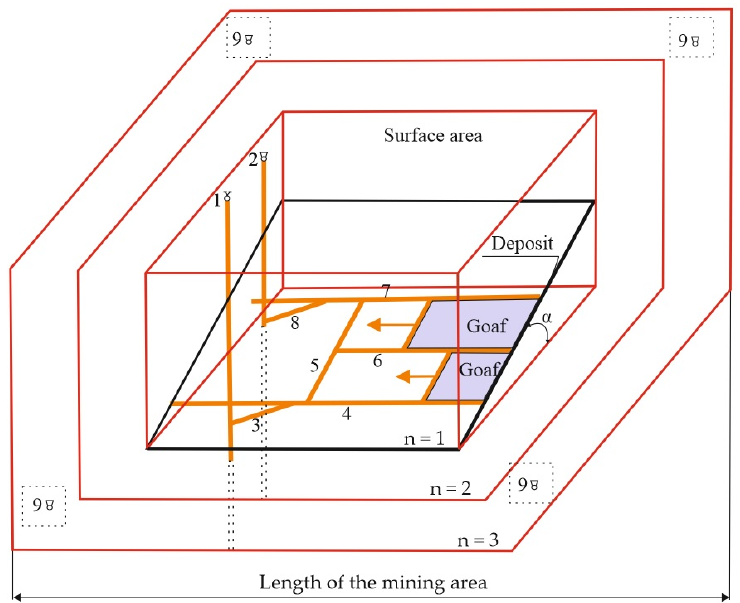
Figure 1. Dimensions of the mining area by the following method: n—number of operating mining levels; 1—output shaft; 2—ventilation shaft; 3—crosscut; 4—transportation gateroad; 5—inclined drift; 6—intermine gateroad; 7—ventilation gateroad; 8—ventilation crosscut; 9—ventilation shafts for expanding mining levels; α —inclination.